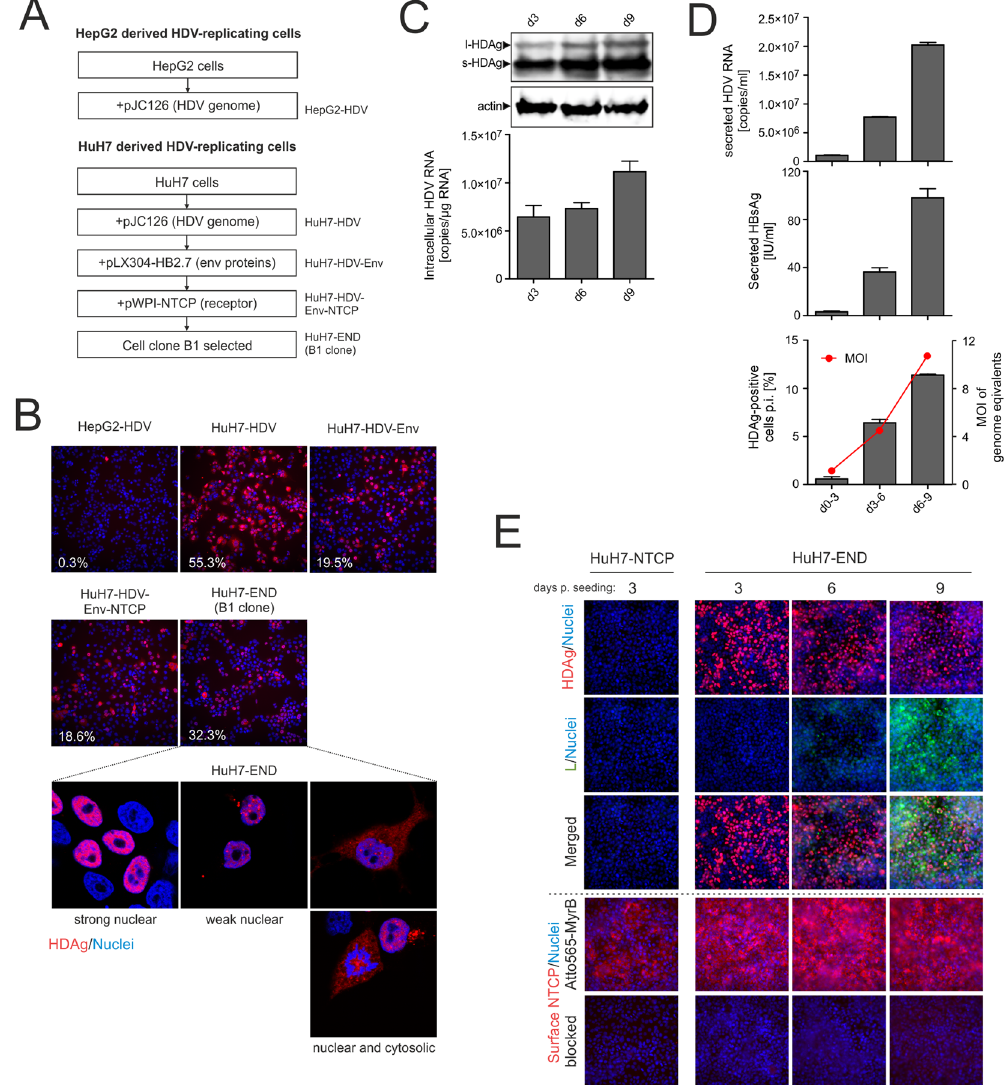
Figure 1. Establishment and characterization of HDV replicating cell lines. ( A ) Generation scheme of a HepG2-derived cell line stably expressing HDV (HepG2-HDV) and HuH7 cells expressing HDV (HuH7- HDV), HDV and the HBV envelope proteins (HuH7-HDV-Env) and HDV, HBV envelope proteins plus human NTCP (HuH7-HDV-Env-NTCP). Finally, a single cell clone of HuH7-HDV-Env-NTCP cells was named as HuH7-END. ( B ) Characterization of the HDV-replicating cell lines described above: HepG2-HDV, HuH7- HDV, HuH7-HDV-Env cells (top row) and HuH7-HDV-Env-NTCP (pool) and clone B1 (middle row) were seeded and stained for HDAg at day 1 post seeding (HDAg in red). Confocal image analyses of HDAg-stained single cells from the HuH7-END cells (lower row) revealed three distinguishable patterns of the subcellular location of HDAg. The numbers given in the pictures indicate the percentage of HDAg-positive cells. ( C ) Western blot analysis of HDAg (top) and quantification of intracellular HDV RNA (below) of HuH7-END cells at d3, d6 and d9 post seeding. ( D ) Analyses of particle secretion of HuH7-END cells. Cell culture medium of the indicated time frames were harvested and quantified for secreted HDV RNA (top), HBsAg (middle). The secreted infectious HDV is determined by the number of HDAg-positive HuH7-NTCP cell post-infection (bottom). For the latter the calculated MOI is shown as the red line. ( E ) Characterization of the HuH7-END cell line with respect to HDAg, HBV L-protein and expression of NTCP. HuH7-NTCP cells (d3 post seeding) and HuH7-END cells at d3, d6 and d9 post seeding were analyzed by IF for HDAg (row 1), HBV L-protein (row 2) and the merged pictures (row 3, HDAg in red, L protein in green). Nuclei were counterstained with Hoechst. Surface NTCP is labelled using 100 nM Atto565-labelled MyrB (row 4). Pretreatment of cells with 2 µ M unlabelled MyrB (row 5) was used to ensure specific NTCP